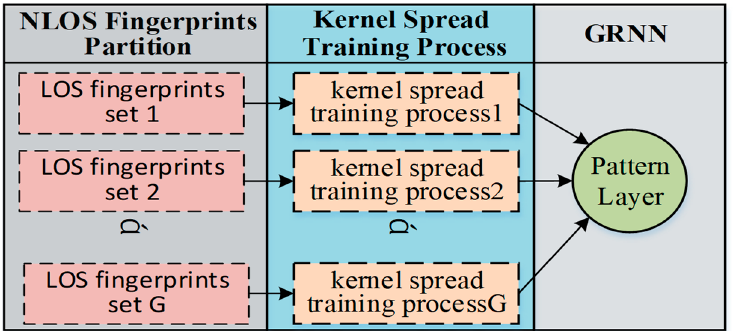
Figure 6. Fingerprints processing diagram in the non-line-of-sight (NLOS) case.